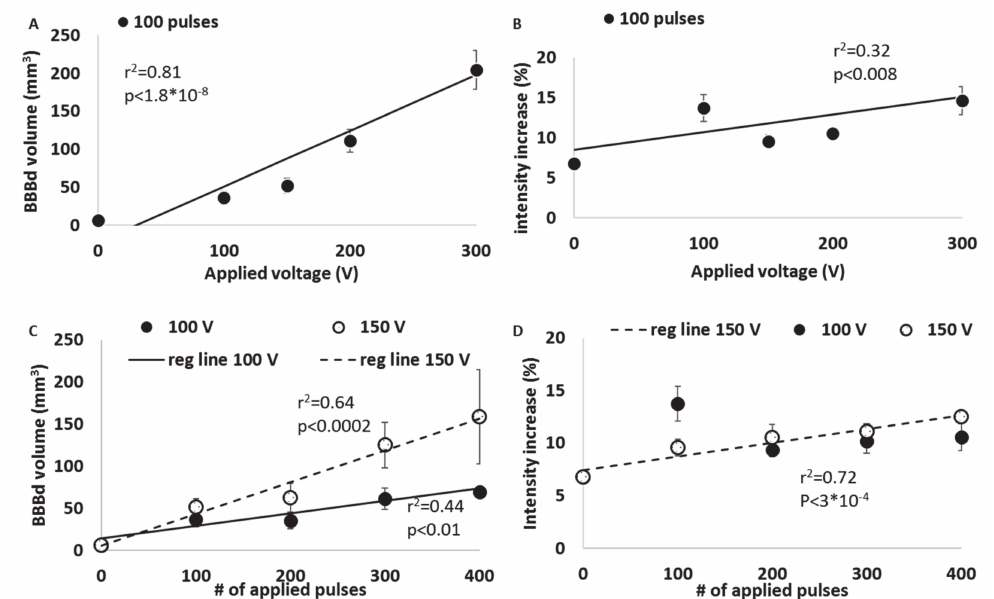
Figure 5. Experimental data and linear regression equation lines describing the dependency of BBBd volume and intensity on the treatment parameters. ( A ) BBBd volume as a function of the applied voltage for 100 pulses. ( B ) BBBd intensity increase as a function of the applied voltage. ( C ). BBBd volume as a function of the number of pulses at 100 and 150 V. ( D ) BBBd intensity increase as a function of the number of pulses at 100 and 150